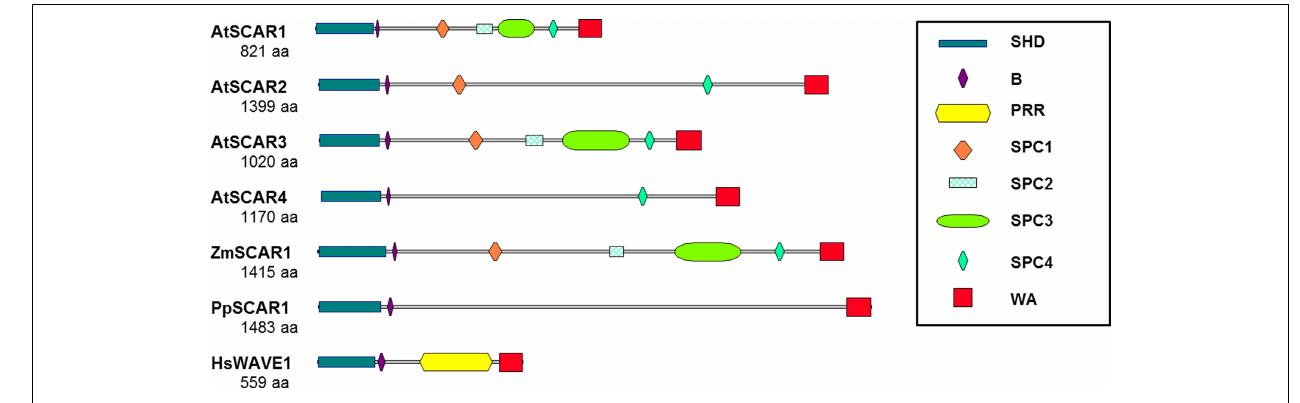
legend to the figure. SCAR sequences are from Arabidopsis (AtSCAR1: NP_001031474, AtSCAR2: NP_181378, AtSCAR3: NP_001117376, and AtSCAR4: NP_195793), maize (ZmSCAR1: AFW80370), moss (PpSCAR1: XP_001754078) and human (HsWAVE1: NP_003922). SHD, SCAR homology domain; B, basic region; PRR, proline-rich region; SPC, SCAR of plant central region;WA,WH2 (W), central, and acidic (A) domains.